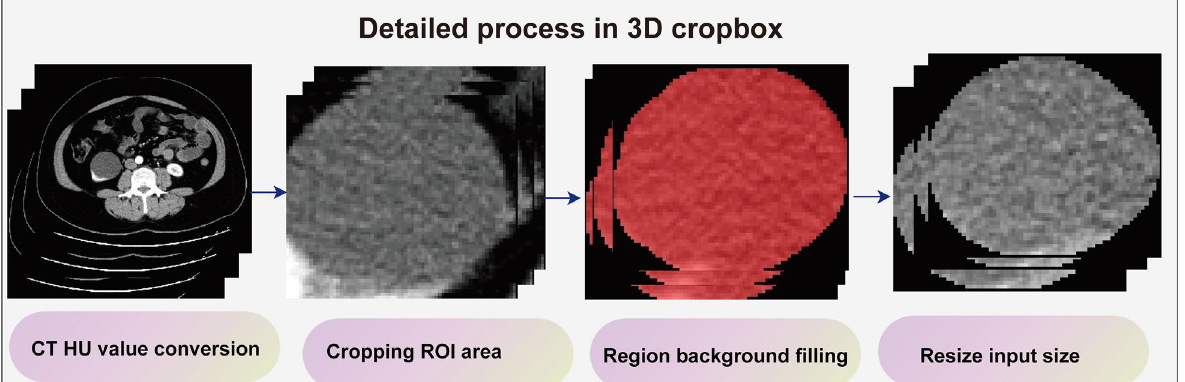
Fig. 2 Detailed workflow of the 3D‑cropbox. 3D‑cropbox consists of four parts: CT HU conversion, ROI area cropping, region background filling, and input size tuning. The area outside the ROI will be filled with black to assure that deep learning features retrieved from the 3D‑cropbox are entirely from